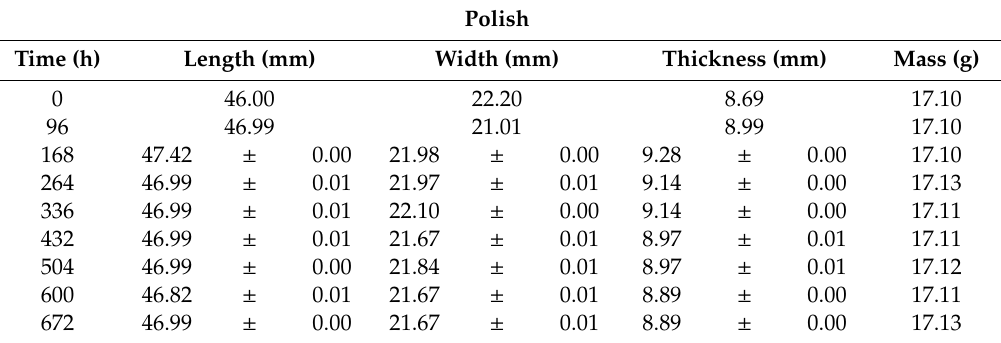
Table 1. Polished sample dimension and mass change measurements.